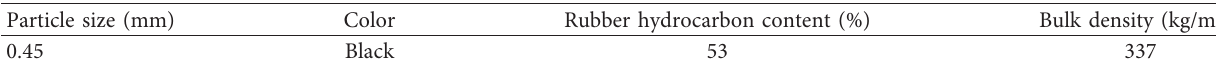
Table 4: Properties of the rubber